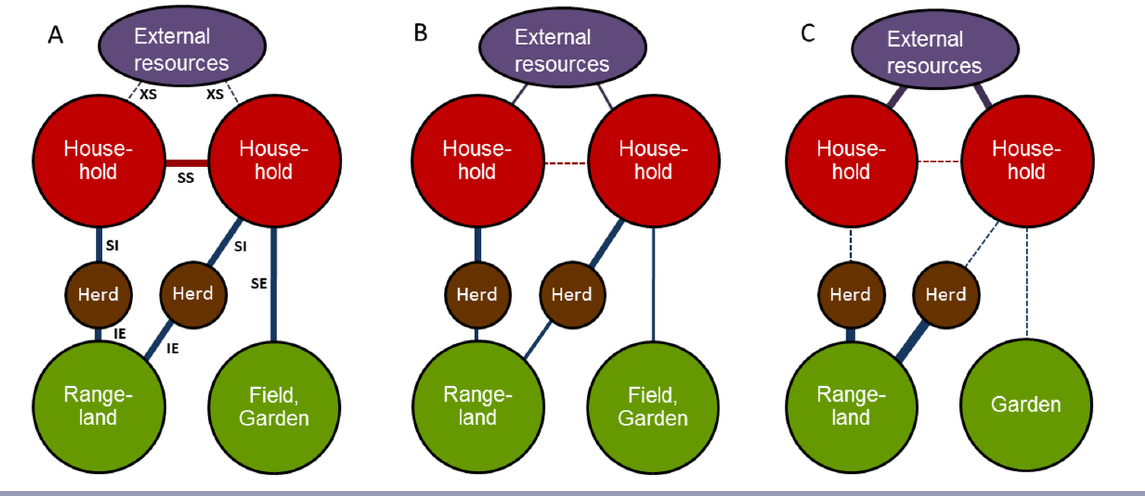
Fig. 3. Novel social-ecological system (SES) motifs (modified from Bodin and Tengö 2012) of three major phases in the focal SES: pre-betterment (A), betterment and homeland (B), and post-apartheid (C). Livestock- owning households (red nodes) are social actors in the social subsystem; rangelands and fields and gardens (green nodes) are natural resources in the ecological subsystem. To this original four-node motif, herds (brown nodes) were added as an interface between subsystems, and a node of external resources was added to account for the open character of the focal SES. Link types show interactions between nodes: external to social (XS), social to social (SS), social to interface (SI), interface to ecological (IE), and social to ecological (SE). Ecological-to-ecological interactions (EE) were not of relevance in the focal SES. Line width illustrates the strength of interactions; dotted lines indicate weak